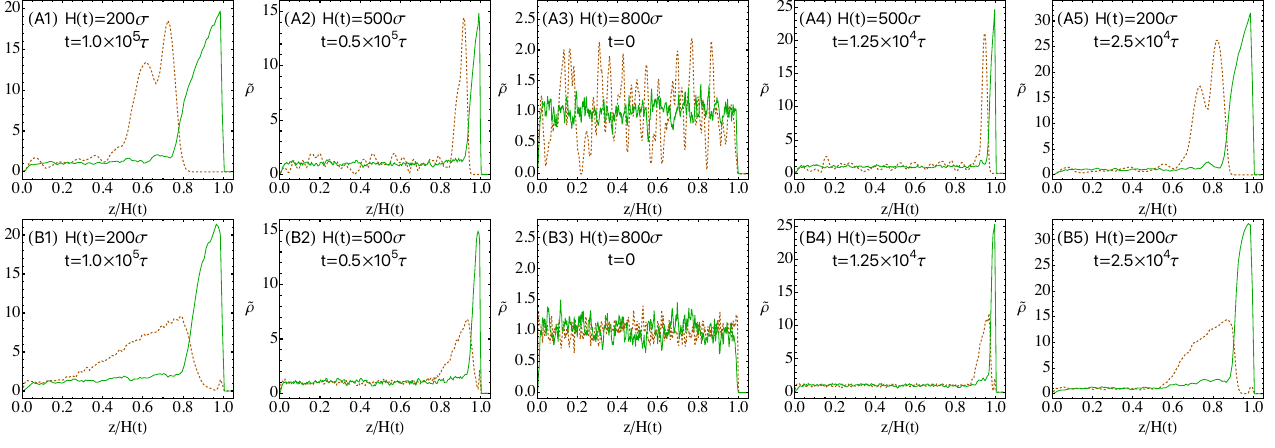
Figure 2. Density profiles of nanoparticles (orange dashed lines) and polymer chains (green solid lines) at various stages of drying for the polymer-MNP mixtures ( A1 – A5 ) and the polymer-SNP mix- tures ( B1 – B5 ). The profiles have a one-to-one correspondence to the snapshots in Figure 1. The equi- librium density profiles are shown in A3 and B3. The sequences A3 → A2 → A1 and B3 → B2 → B1 are for v e = 0.006 σ / τ , while the sequences A3 → A4 → A5 and B3 → B4 → B5 are for v e = 0.024 σ / τ